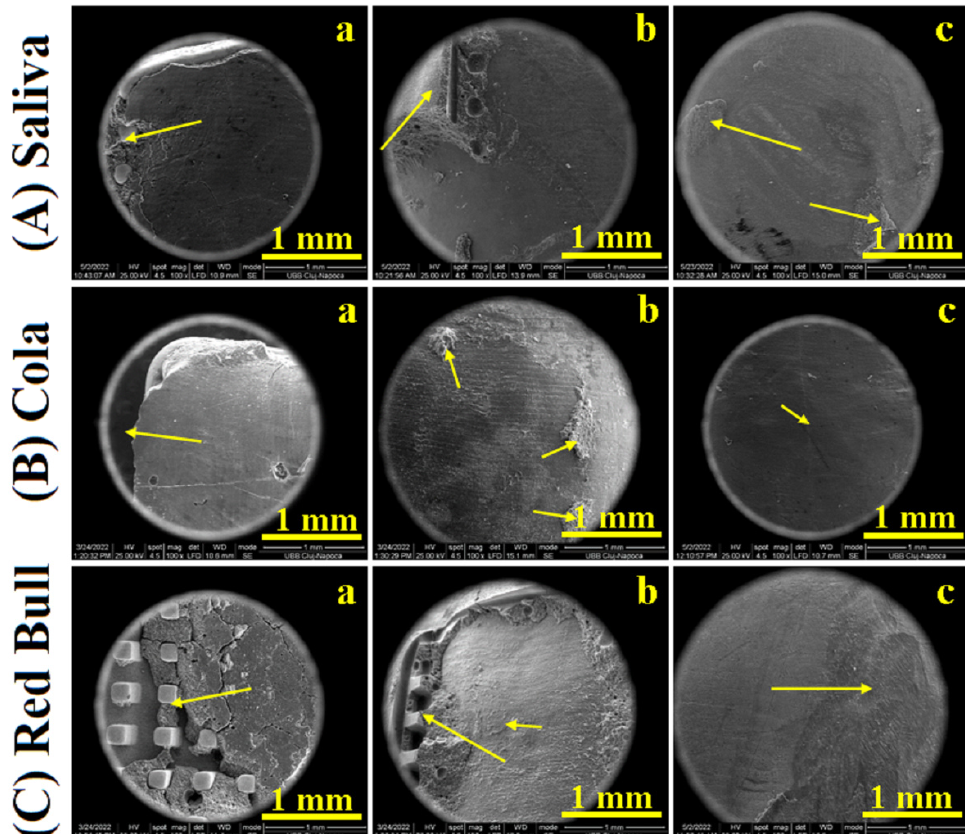
Figure 2. SEM images of RMGIC samples: ( a ) bracket after debonding, ( b ) enamel after debonding, and ( c ) debonded enamel after polishing; stored in Saliva ( A ), exposed to Cola ( B ) and exposed to Red Bull TM ( C ).